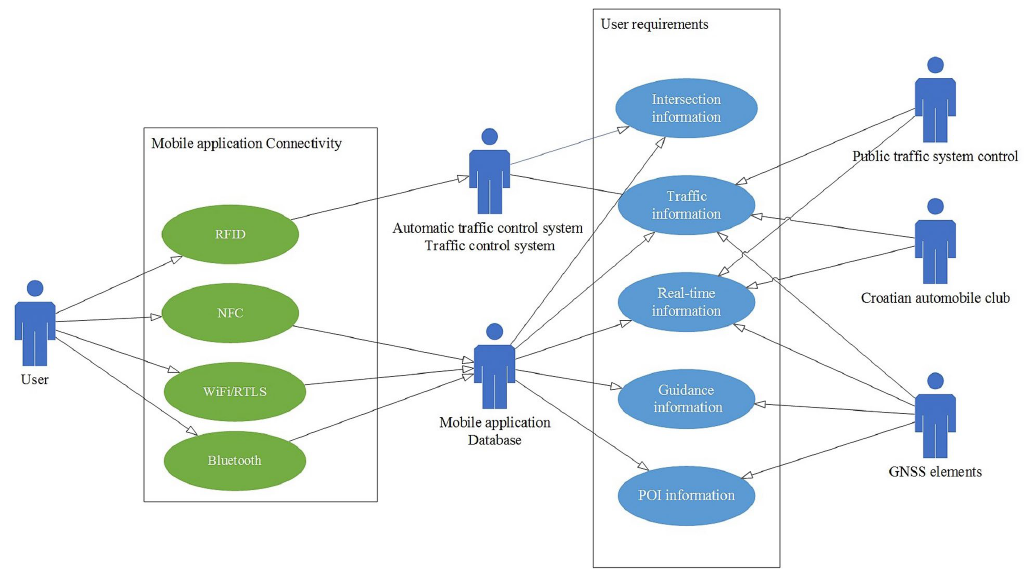
Fig. 2. The preview of fulfilling of user requirements based on different mobile application connectivity